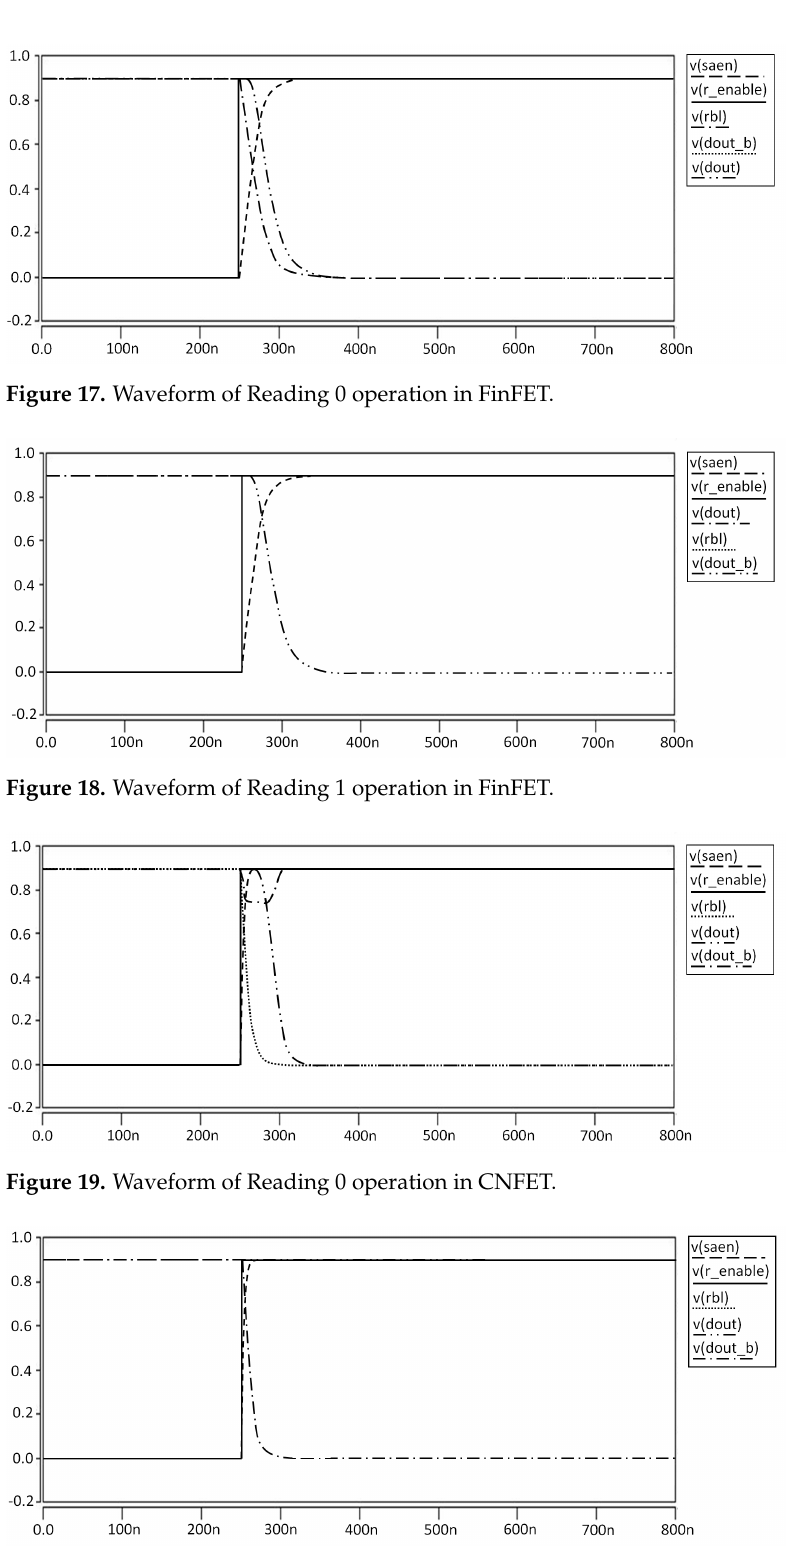
Figure 20. Waveform of Reading 1 operation in